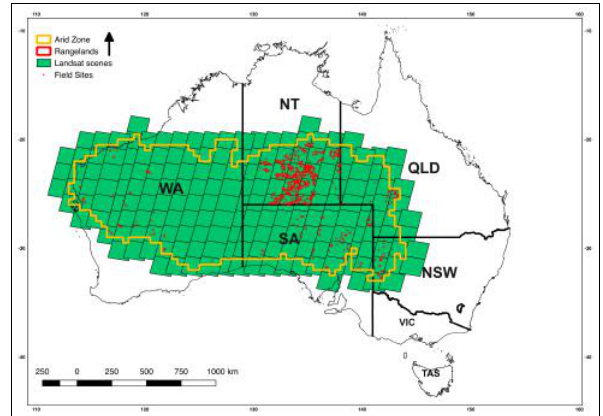
Figure 4. Location of fractional ground cover field measurement sites and Landsat imagery extents.